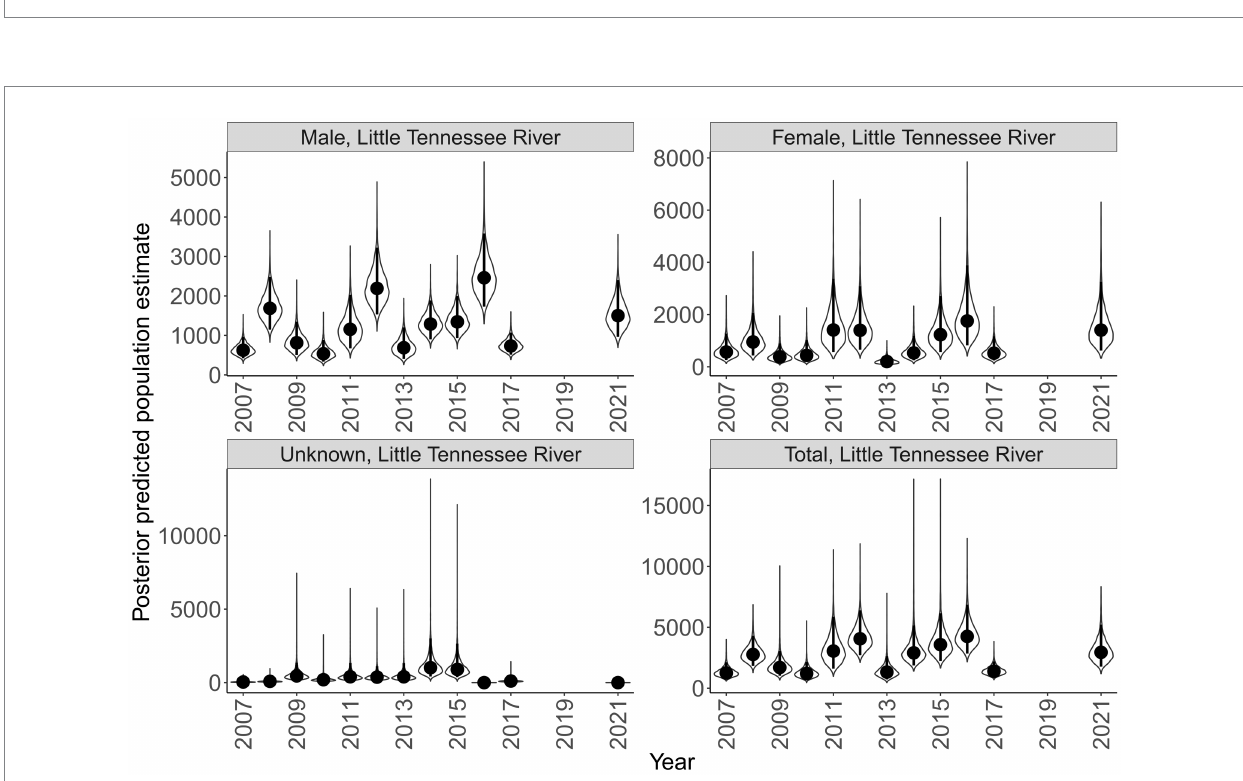
FIGURE 7 Annual population estimate of Sicklefin Redhorse Moxostoma sp. in the Little Tennessee River by sex and all sexes combined. Years without a plot indicate river was not sampled. Violin plots represent the shape of the full posterior distribution, dark circles represent the median of the posterior distribution, and solid vertical lines represent the bounds of the 95% credible